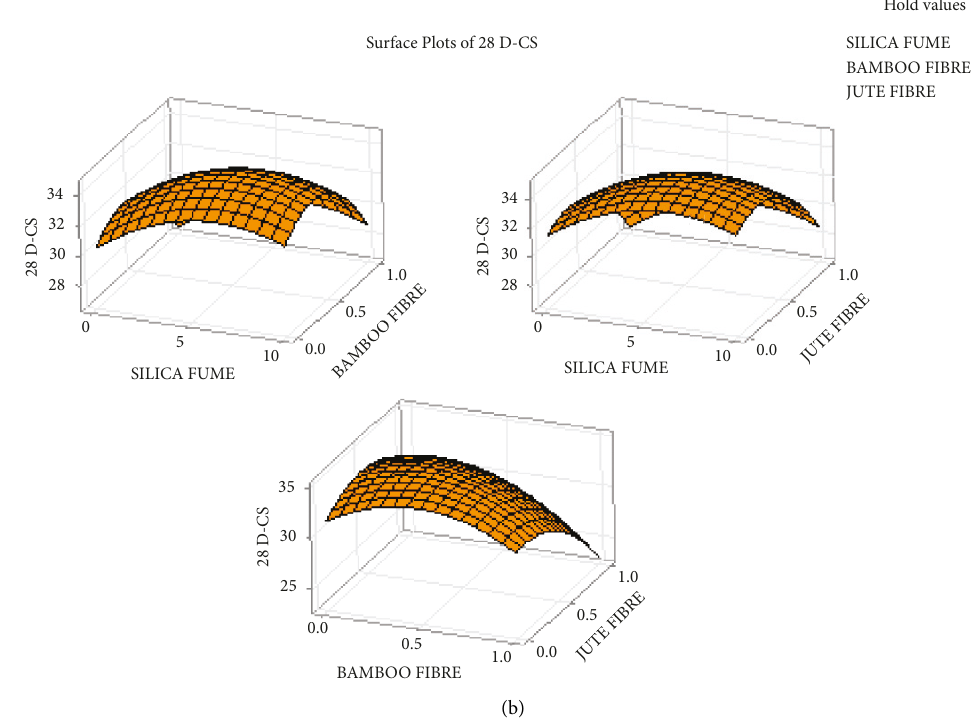
and (b) fcs 14 28